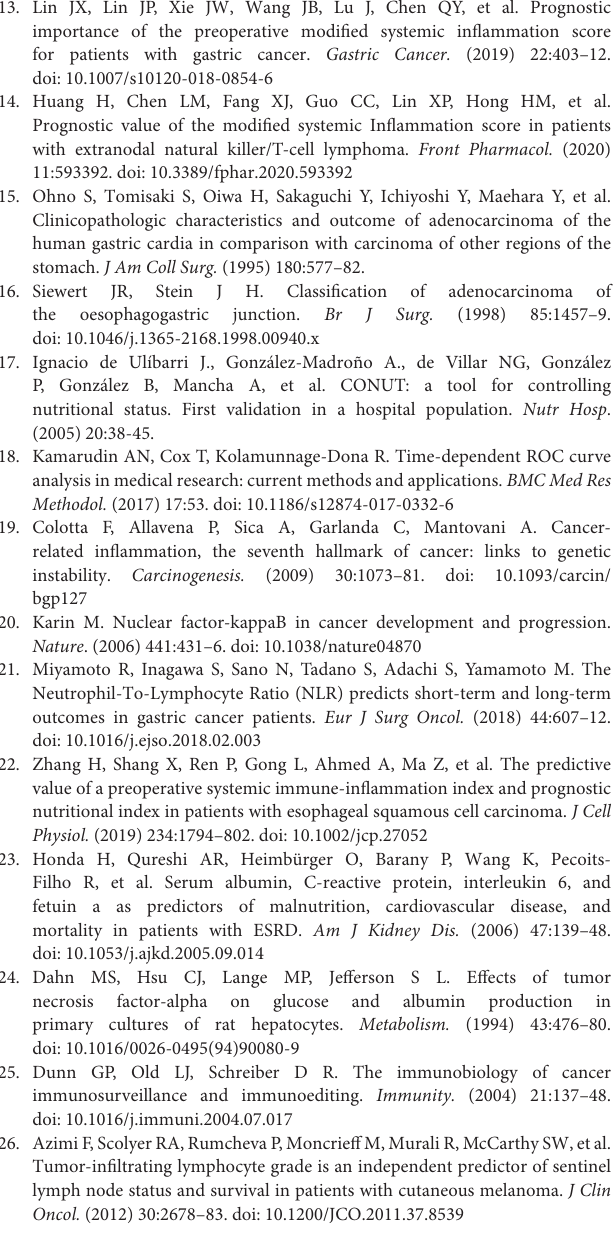
Supplementary Table 1 | The definition of modified mSIS. mSIS, modified systemic inflammation score; ALB, albumin; LMR, lymphocyte-to-monocyte ratio.